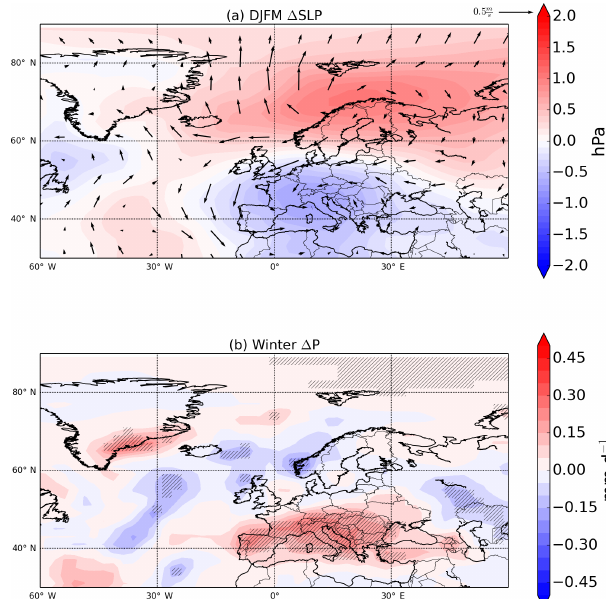
Figure 5. Wintertime response in sea level pressure, surface winds (a) , and precipitation (b) to an 80% reduction of European SO 2 emissions in GFDL-CM3. Hatching indicates statistical signifi- cance at the 95% confidence